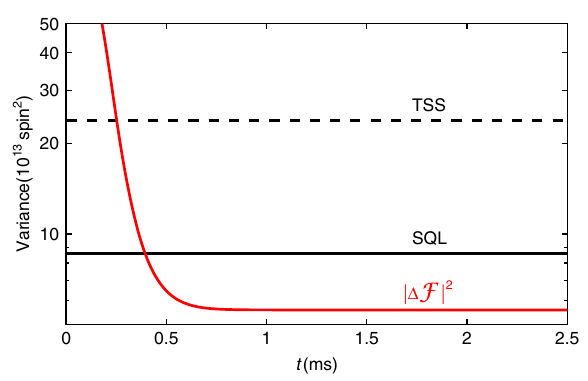
Fig. 6 Spin variance versus Kalman fi lter (KF) tracking time. The dashed black line and solid-black line are thermal spin state (TSS) noise level and standard quantum limit (SQL) for total spin. Probe power = 2 mW, ν = 1.3 kHz. L